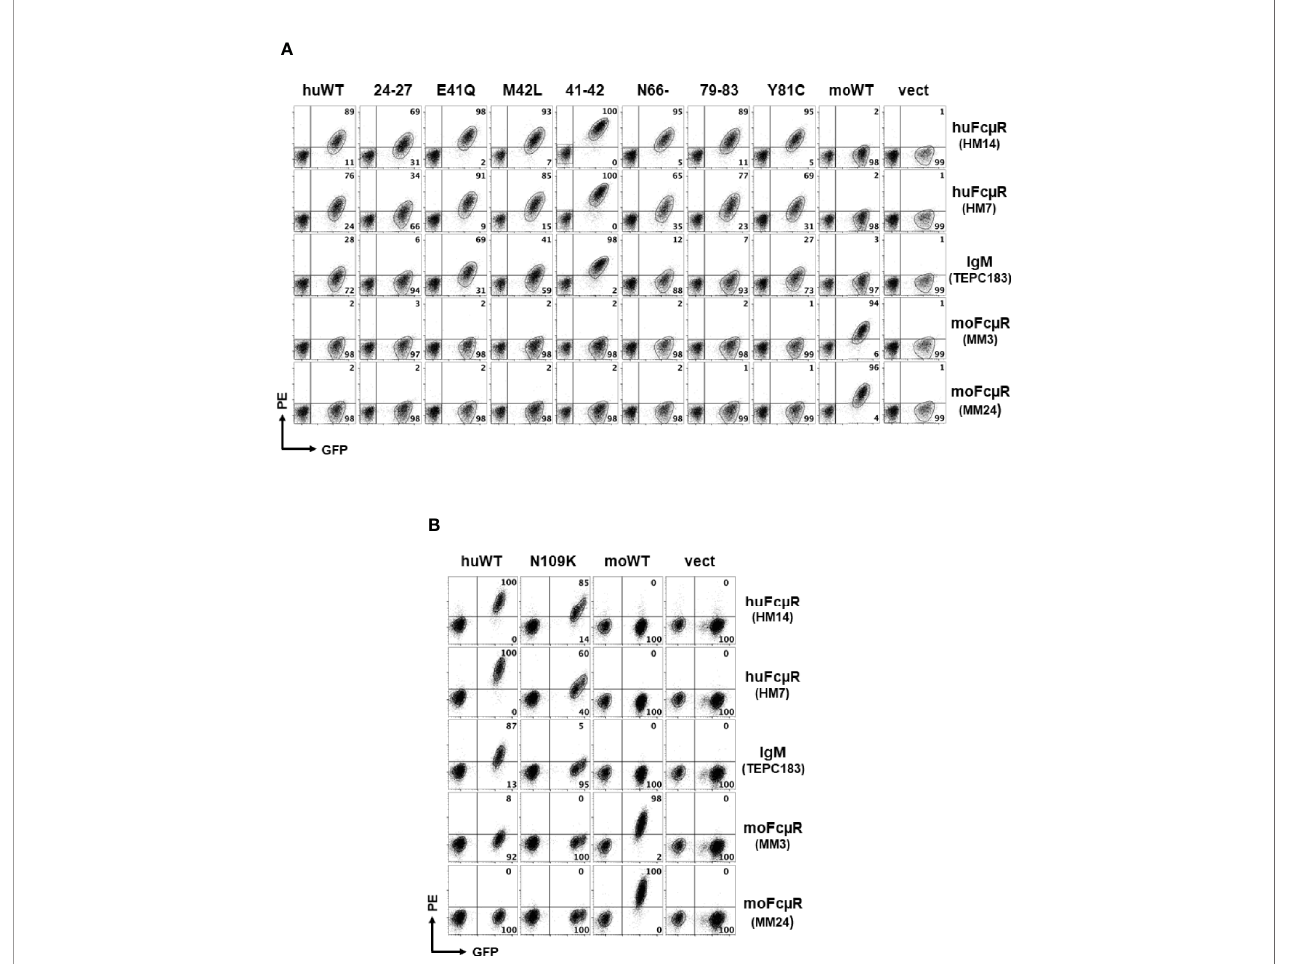
FIGURE 2 | Representative pro fi les of receptor expression and IgM binding by cells with wild or mutant type of human FcµR. An equal mixture of GFP-negative control cells and GFP-positive cells transduced with the indicated cDNAs ( top label ) was incubated with the indicated FcµR-speci fi c mAbs or a mouse IgM paraprotein ( right label ), before developing with PE-labeled goat anti-mouse Ig antibodies. The stained cells were analyzed by FACSCanto ll. HM14 ( g 1 k ) and HM7 ( g 2b k ) mAbs are speci fi c for an epitope in the stalk region or the ligand binding site of human FcµR, whereas MM3 ( g 1 k ) and MM24 ( g 2b k ) mAbs are speci fi c for an epitope in the stalk region of mouse FcµR. (A) Cells transduced with cDNA encoding human FcµR of wild (huWT) or mutant type [KVEG24- 27QLNV (24 – 27), E41Q, M42L, EM41-42QL (41 – 42), N66-, KQYPR79-83TPCLD (79 – 83), and Y81C], mouse FcµR (moWT) or vector only (vect) are shown. (B) Cells transduced with human FcµR N109K mutant are shown along with huWT, moWT and vect controls. Numbers in A and B indicate % cells in each quadrant among the indicated GFP + cell